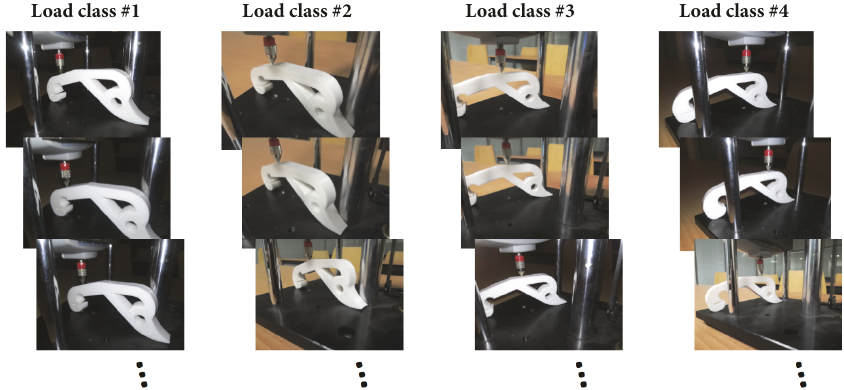
Figure 6: Sample images for each of the four loading environment classes.